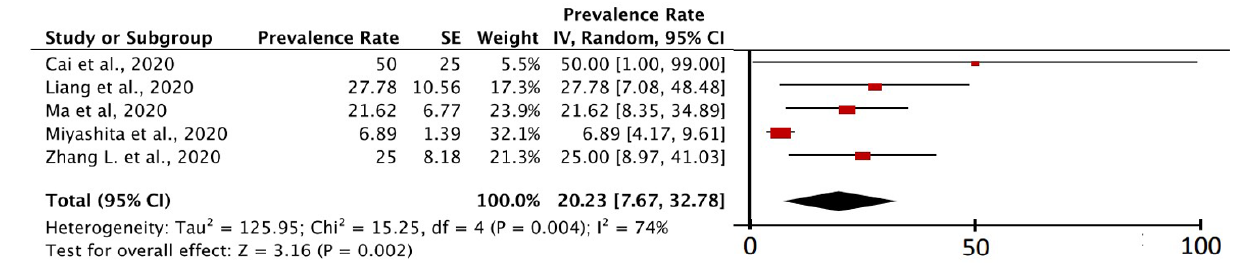
Figure 6. Forest plot of lung cancer prevalence in cancer patients with COVID-19.